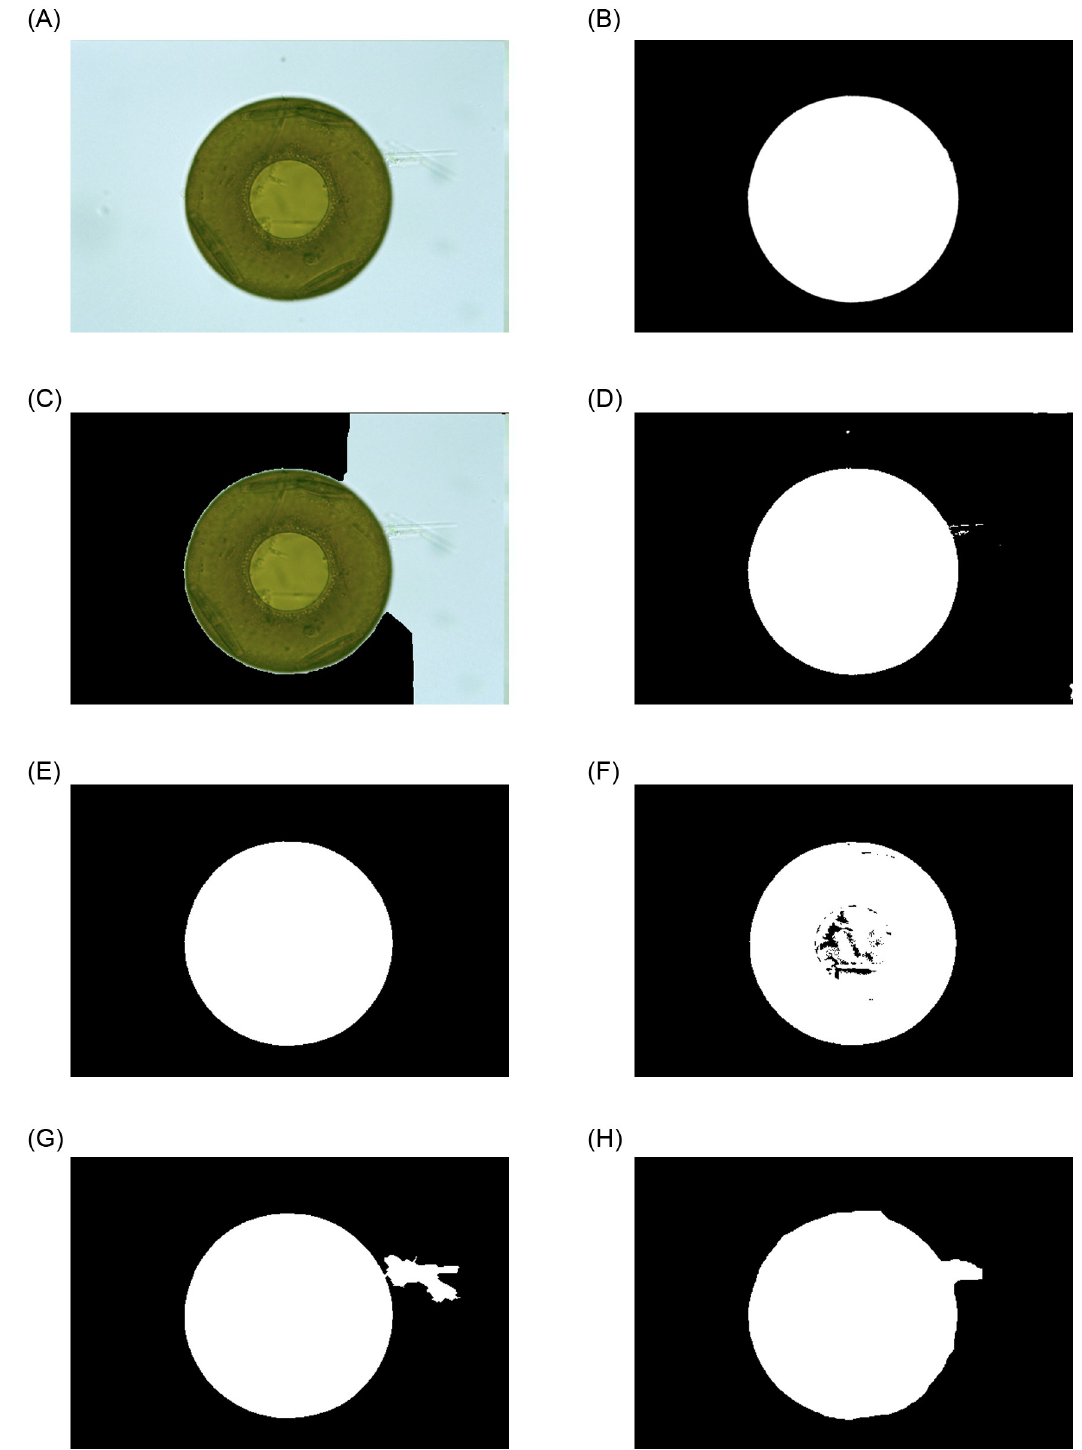
Fig 5. An example of different single-object segmentation results using EMDS-5 images.